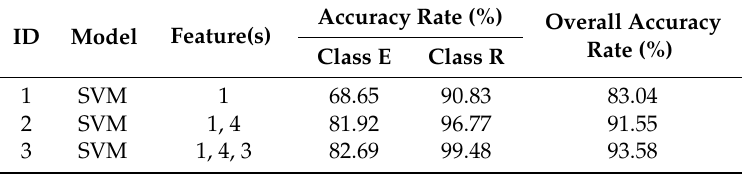
Table 5. The classification result using the three features.